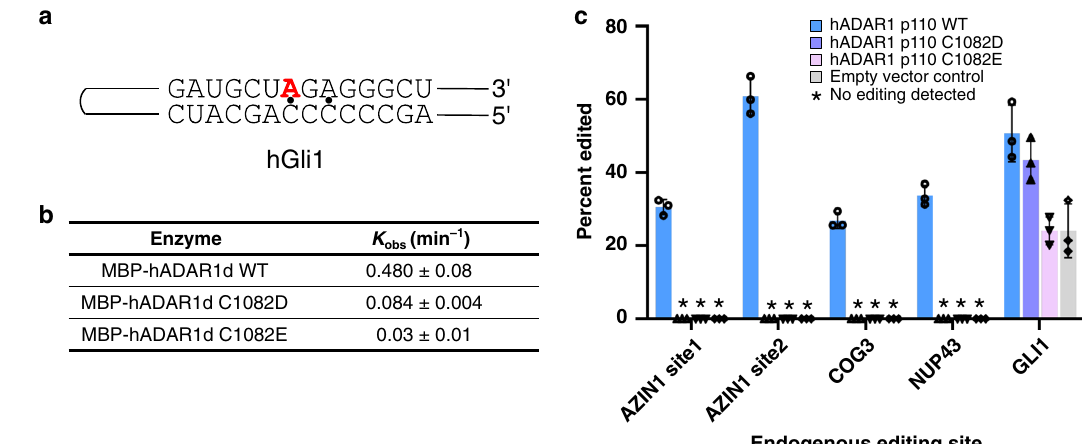
Fig. 6 Analysis of catalytic activity of hADAR1 showing importance of the second metal-binding site. a Sequence of hGli1 RNA substrate used for in vitro deamination kinetics study. Highlighted in red is an editing site. b MBP-hADAR1d WT and metal-binding mutants (C1082D and C1082E) deamination kinetics. hGli1 RNA (10nM) and 750nM of each protein were used. Data are presented as the mean±s.d. from three independent replicates. c Endogenous target site editing of hADAR1 p110 WT and metal mutants (C1082D and C1082E) in HEK293T cells. Individual data points from hADAR1d p110 WT, C1082D, C1082E, and empty vector control are represented as circles, up-pointing triangles, down-pointing triangles, and diamonds, respectively. Asterisk indicates no editing observed. Data are plotted as the mean±s.d. from three biological replicates. Source data for Figs. 6b, c are provided in the Source Data fi le.